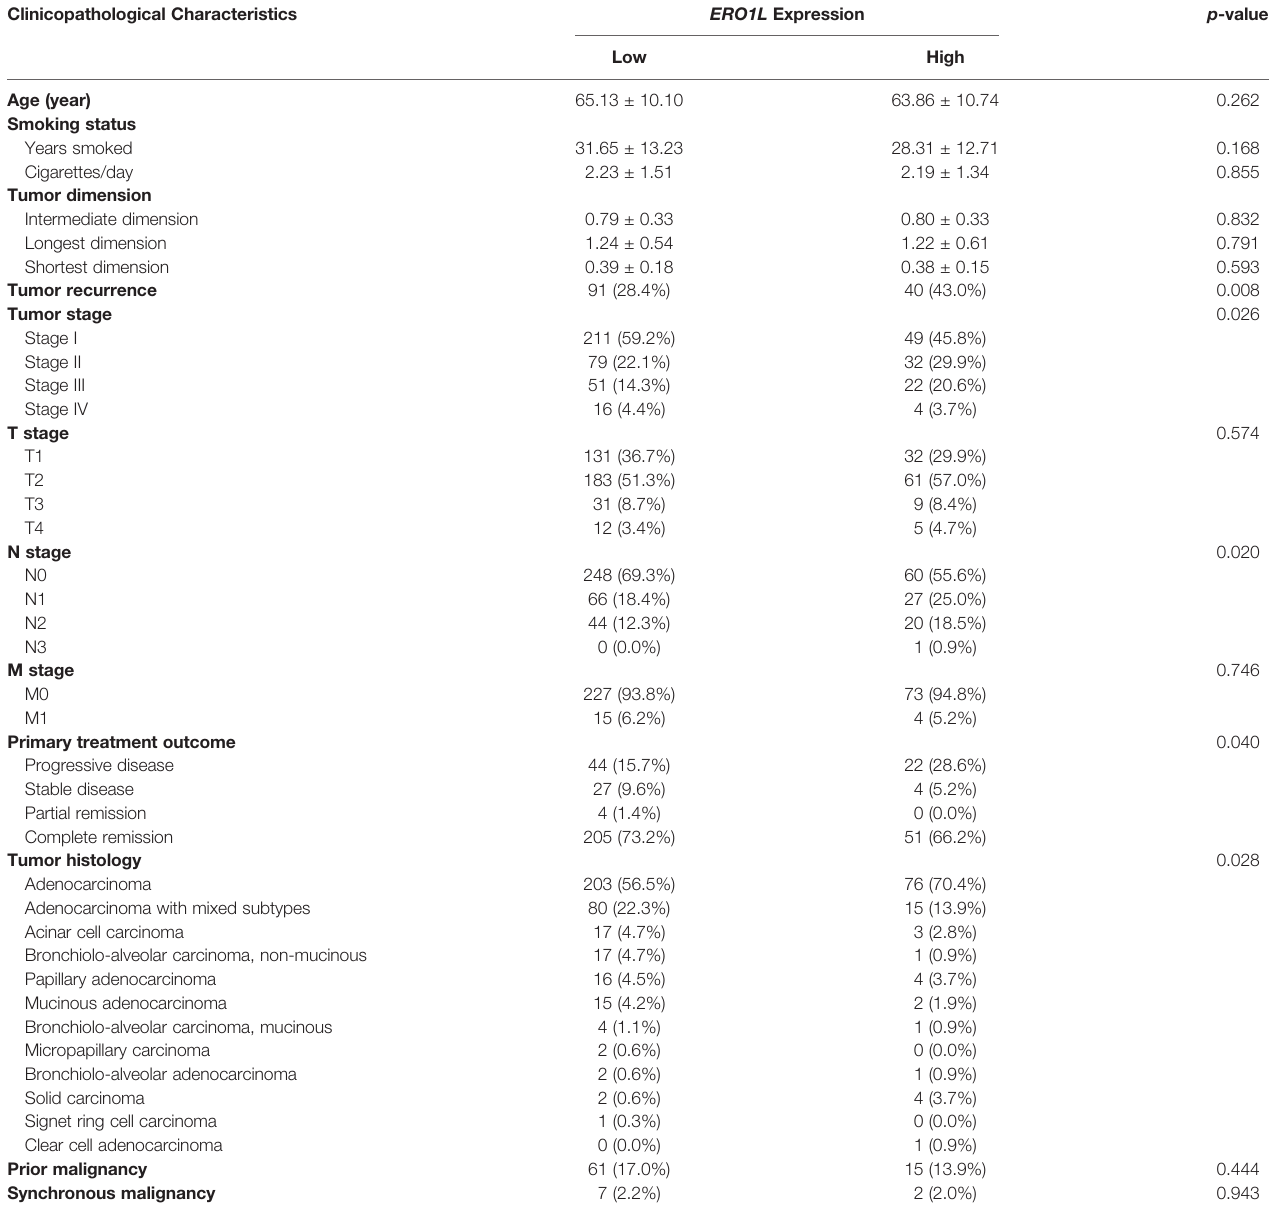
TABLE 1 | Correlation between ERO1L and clinicopathological characteristics in patients with lung adenocarcinoma. Clinicopathological